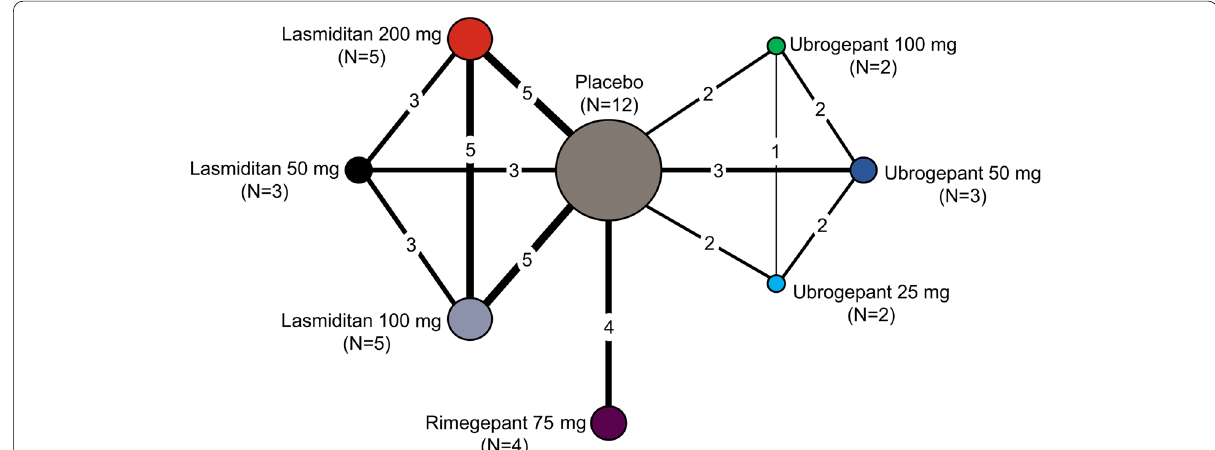
Fig. 2 Network diagrams: base case analysis for pain freedom at 2 hours a (12 randomised controlled trials). a Assessed using Bayesian fixed-effects model adjusted for baseline risk (36 observations; residual deviance 36.26). Lines are weighted according to the number of studies comparing the = two treatments, and the radius of the circle indicates the number of studies within a given treatment